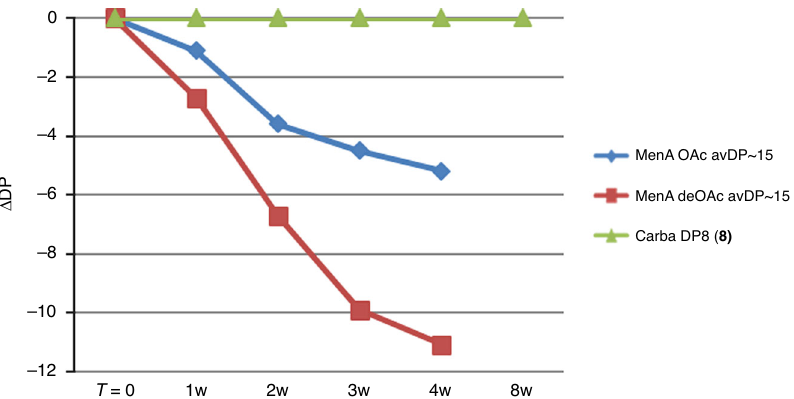
Fig. 3 Stability of carba DP8. The sugar analog was compared to acetylated and de-O-acetylated MenA CPS avDP – 15 at 37 °C in 5 mM NaOAc pH 7; Δ DP was measured as a function of the time based on 31 P NMR pro fi le, as shown in Supplementary Fig. 1.